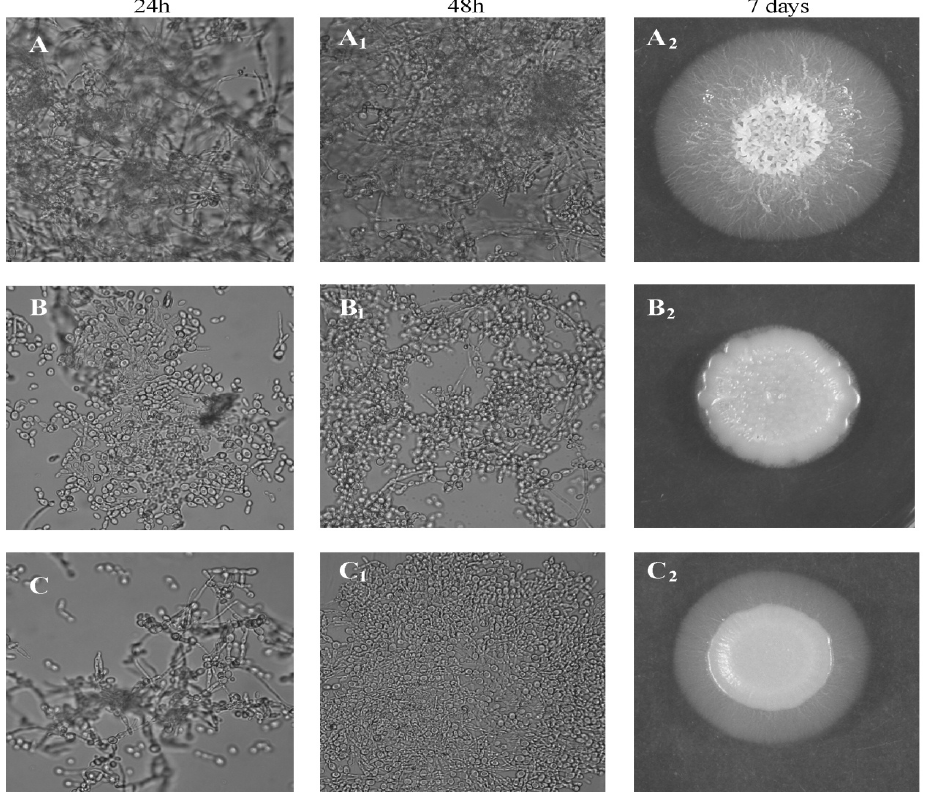
Figure 4. Hyphae formation (left and middle columns) by C. albicans ATCC 10231 strain cultured in RPMI-FCS medium in the absence ( A , A ) or presence of T. alexandrinum 1 SAPF at concentration of 0.25 mg/mL ( B , B ) or at concentration of 0.125 mg/mL ( C , C ), 1 1 tested after 24 h or after 48 h. At the indicated time points of culture, samples were withdrawn, evaluated microscopically (light microscope 400× magnification). Mycelium formation (right column) by C. albicans ATCC 10231 colonies grown for 7 days at 30 °C on ( A )—control Spider medium; ( B )—Spider medium + SAPF 0.25 mg/mL; 2 2 )—Spider medium + SAPF 0.125 mg/mL. The presence or lack of hyphal growth at the ( C 2 colony edges was determined using a stereomicroscope (12× magnification). The presented images are representative from two independent